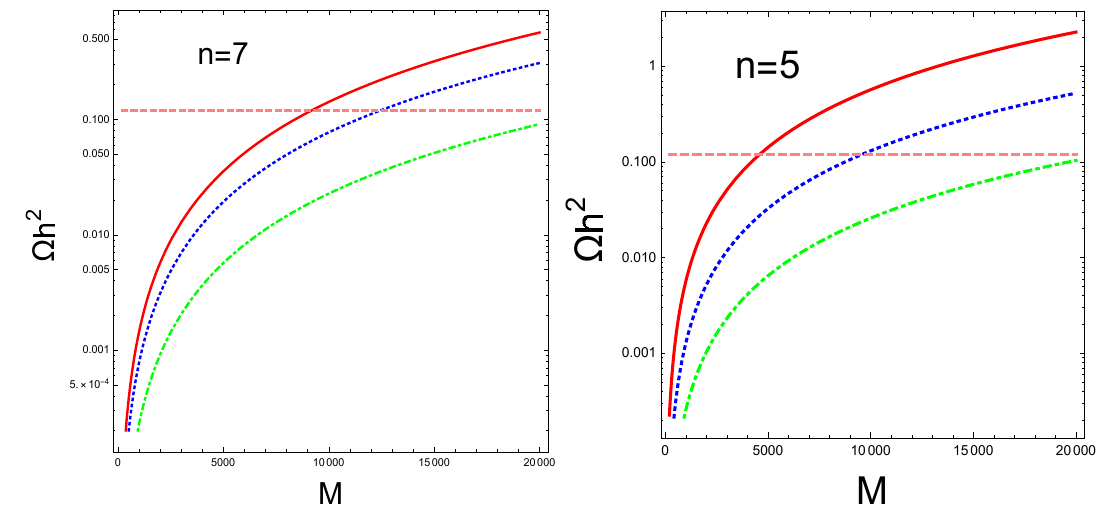
Figure 1 . Dark matter relic density as a function of the dark matter mass. The solid (red), dashed (blue), and dot-dashed (green) curves correspond to (cid:21) e(cid:11) = 0 ; 2 ; 5, respectively. The horizontal line is the observed relic